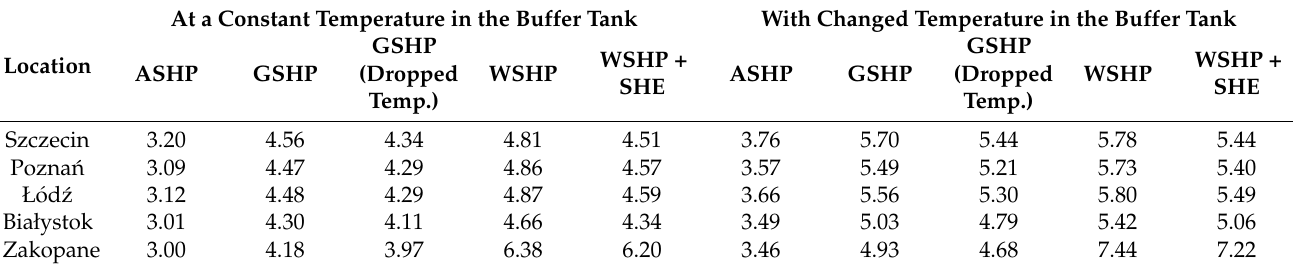
Table 10. The results of (SCOP net ) obtained from Equation